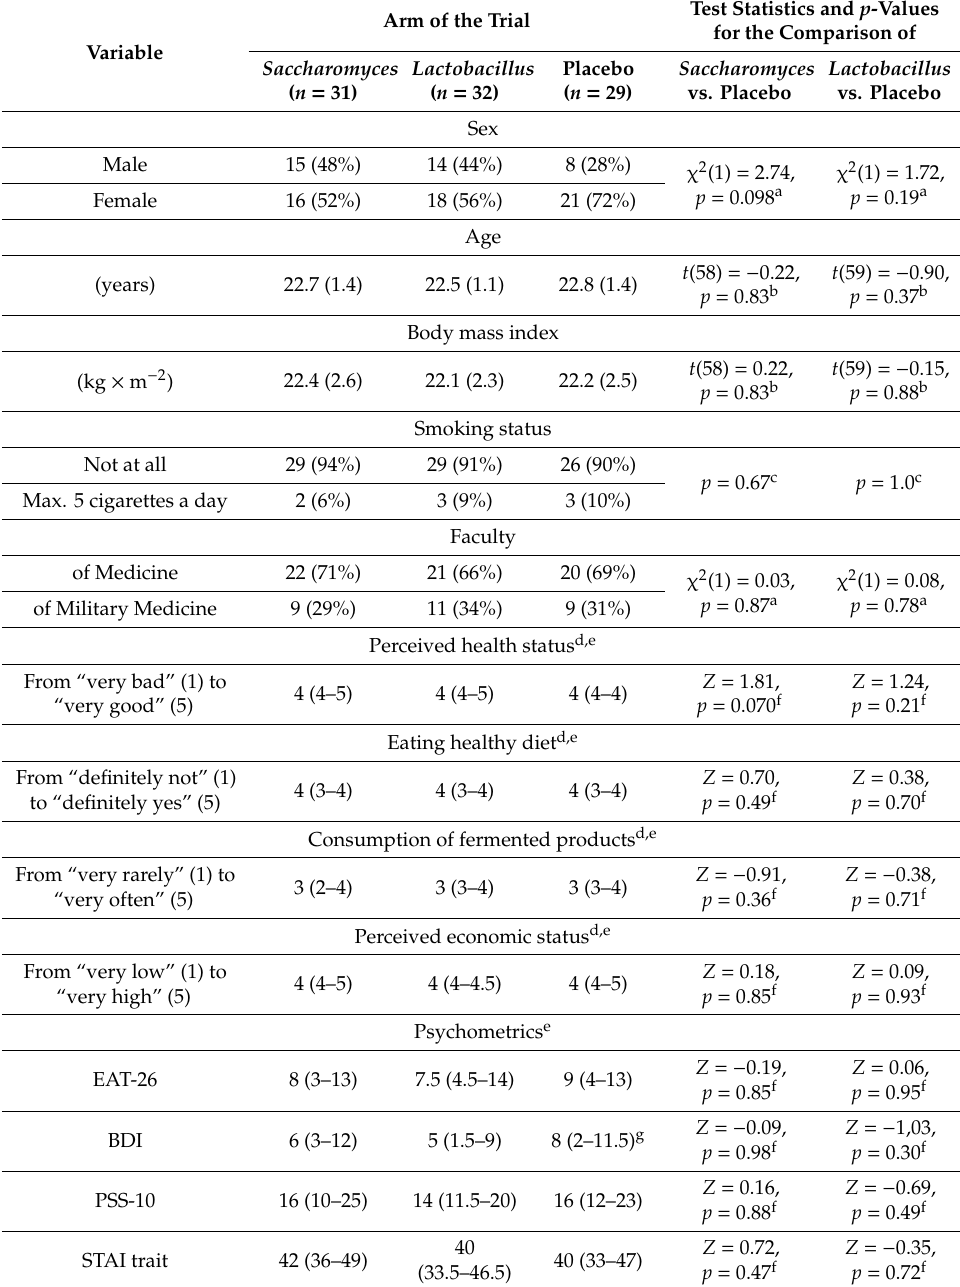
Table 1. Basal sociodemographic, psychometric, and laboratory characteristics of the participants enrolled to the study: The results include means and standard deviations or absolute and relative frequencies, if not stated